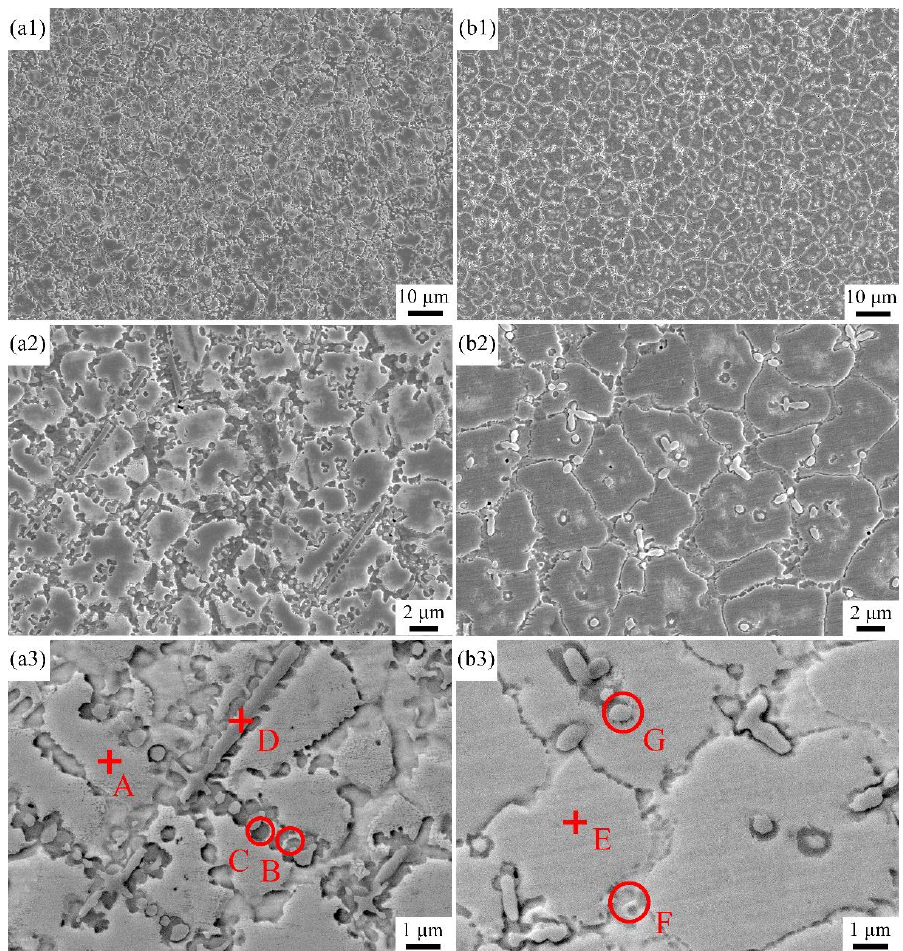
Figure 5. SEM and BSE images of the microstructure of the coatings: ( a1 – a3 ) coating without Al and ( b1 – b3 ) coating with Al. Table 2. EDS analyses of chemical compositions (at.%) for the marked zones are shown in Figure 5.